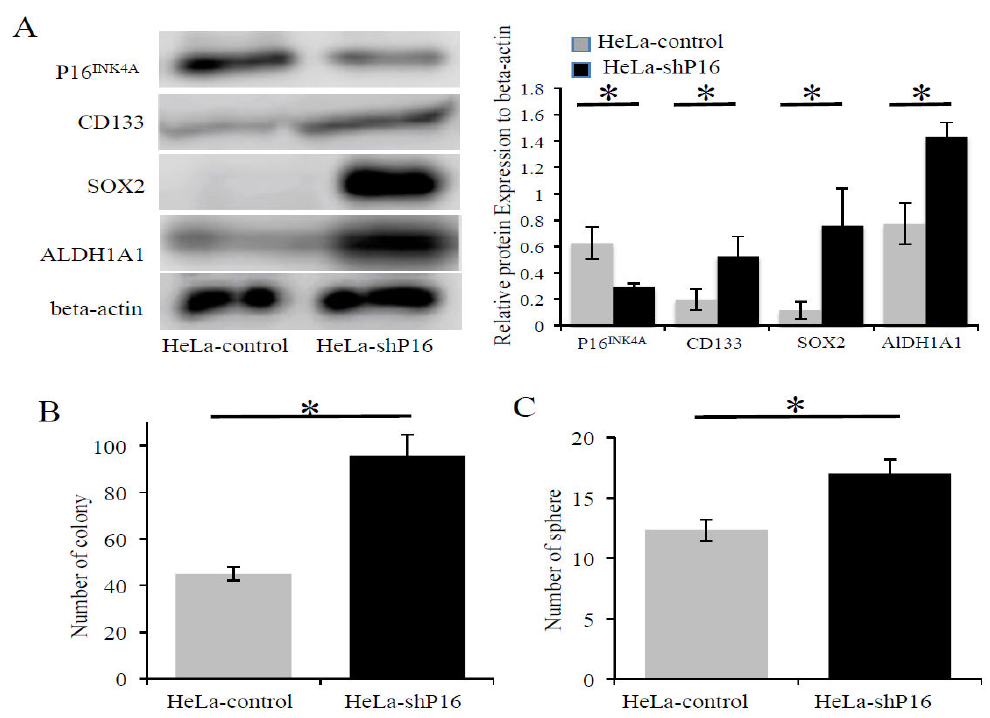
Figure 5. The inhibition of P16 INK4A protein expression increased SOX2, ALDH1A1 expression, and self-renewal ability in cervical cancer cells. ( A ) Expression of stem cell markers (CD133, SOX2, and ALDH1A1) at the protein level in the HeLa-control and HeLa-shP16 cells were detected by Western blot and relative protein expression to beta-actin protein was shown. ( B ) Colony formation assay of HeLa-control and HeLa-shP16 cells were used to evaluate the ability of self-renew. ( C ) The sphere formation assay was used to measure the anchorage-independent growth of HeLa-control and HeLa-shP16 cells in ultra-low attachment plates. Each bar represents the mean ± SD of three independent experiments. Student’s t -test was used for continuous variables between the two groups. * p < 0.05. Data are presented as the mean ± SD of three independent